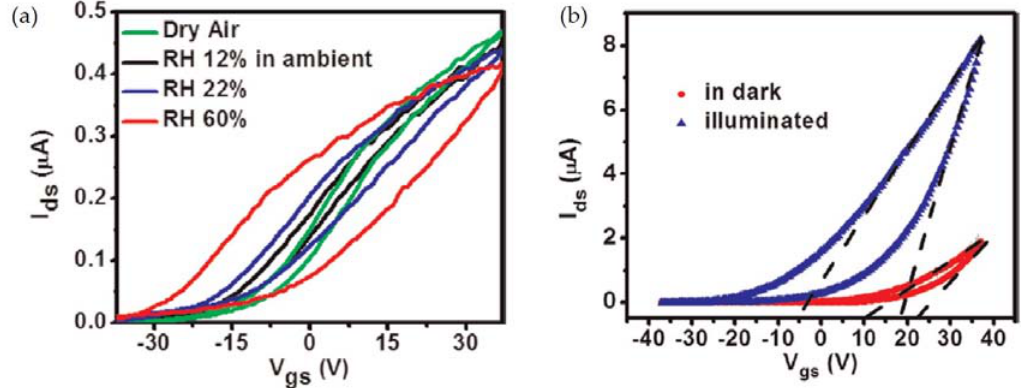
Figure 7. ( a ) Hysteresis in the monolayer MoS 2 transistor with controlled humidity under the sweeping rate of gate voltage at 0.5 V/s and V ds = 0.5 V. ( b ) Hysteresis with different illumination conditions in a monolayer MoS 2 transistor. Blue dots are under global white illumination (0.7 mW/cm 2 ), and red dots are in the dark. The intersections between the dashed lines, and y = 0 show the threshold voltages. Reproduced with permission from [99], American Chemical Society, 2012.